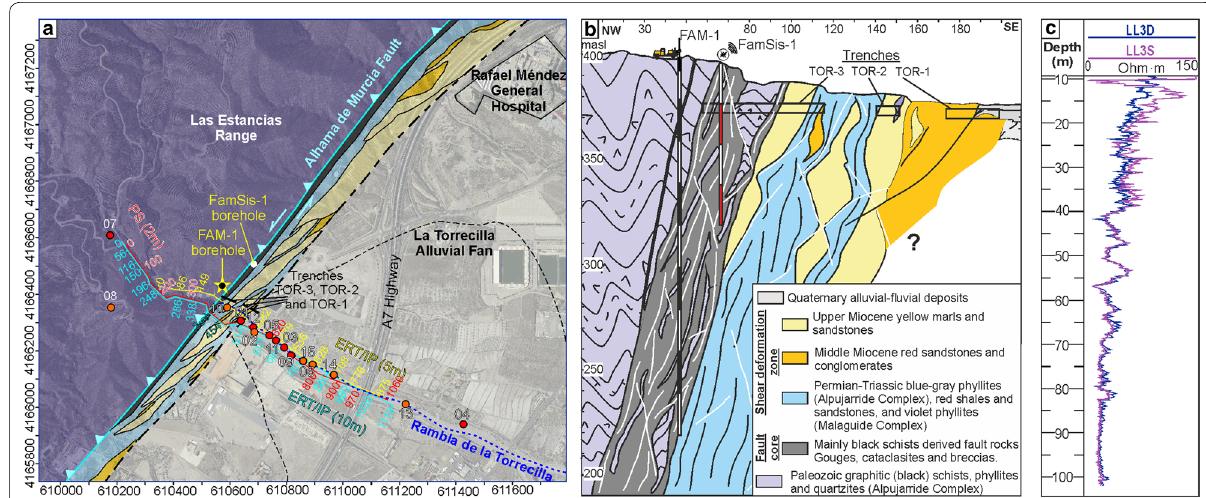
Fig. 6 a Combined aerial photo and geological map of the La Torrecilla area showing the main trace of the AMF and the geological units compounding the fault zone ( b ). The location of the MT, the FAM‑1 and FamSis‑1 boreholes are also shown, in addition to the position of the geophysical profiles in Fig. 9. b Geological cross section constructed from borehole logging information and trenches Tor‑1, Tor‑2, and Tor‑3. c Resistivity log from FAM‑1, up to 100 m depth (modified from Martínez‑Díaz et al.